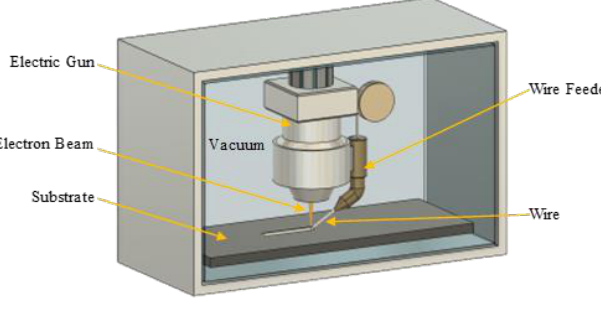
the raster 90 tool path is angled 90 ◦ from the x-axis of the build table; Figure 2 shows this tool path. Raster is a 0 ◦ raster tool path and the linear sample follows a path around the perimeter with a 45 ◦ infill.